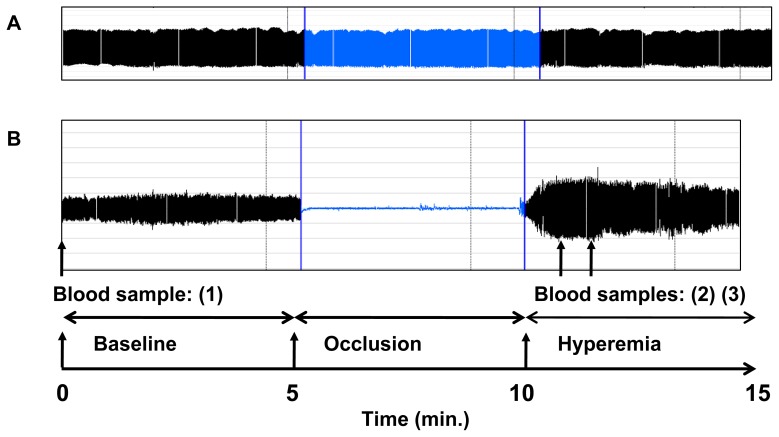
Study design.Combination of finger plethysmography (peripheral arterial tonometry, EndoPAT) with venous blood sampling from the same arm for EPR measurements of HbNO level. Changes of pulse amplitude, recorded by EndoPAT probes at baseline, during arterial occlusion (with a brachial cuff), and during reactive hyperemia (after cuff deflation) at the tip of the index finger of the ischemic arm (B) and contralateral finger of control arm (not undergoing reactive hyperemia) (A). Blood sampling for HbNO EPR assay was done at baseline (sample 1) before EndoPAT signal recording and at 1 (sample 2) and 2 (sample 3) minutes post-deflation of the cuff (post-occlusive hyperemia).